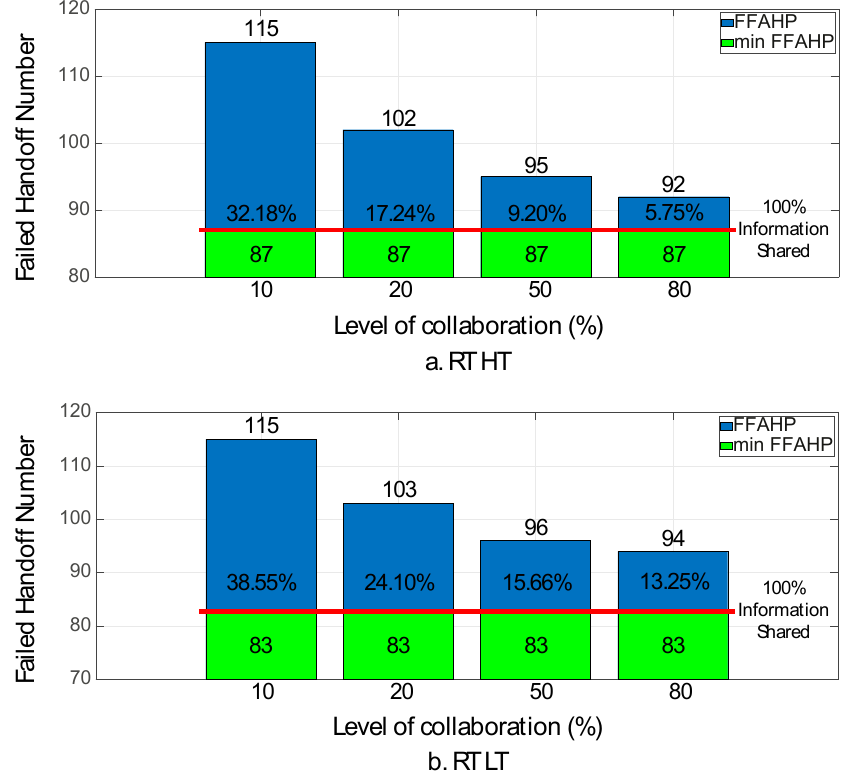
Figure 19. Relation of failed handoffs for FFAHP: ( a ) Real time (RT) and high traffic (HT); ( b ) Real time (RT) and low traffic (LT).